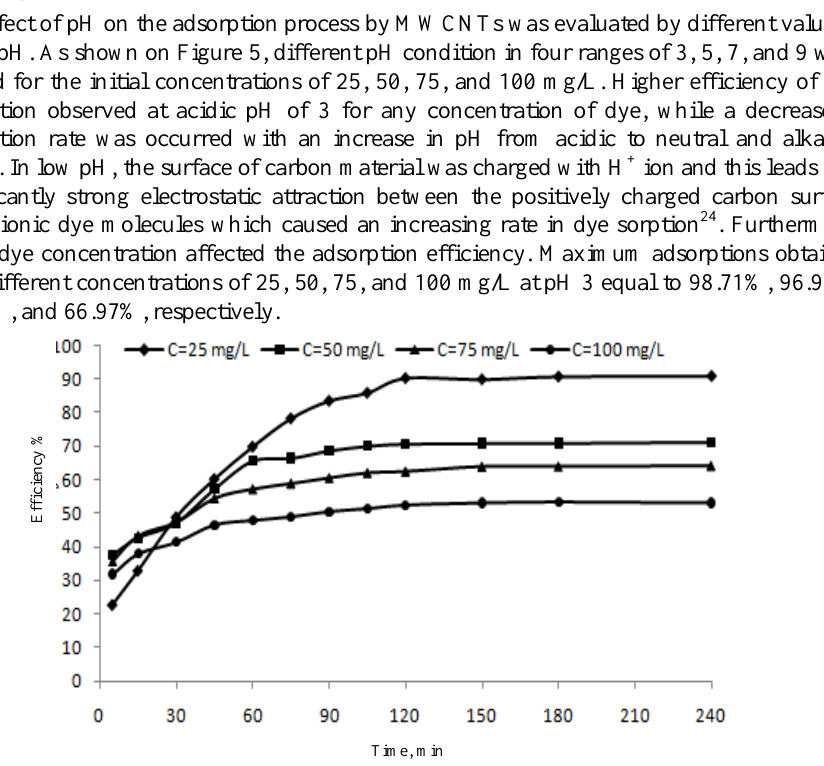
Figure 4 Effect of contact time on adsorption of AR18 to MWCNTs in different dye concentrations (pH=5, MWCNTs= 0.2 g/L, T=25 o